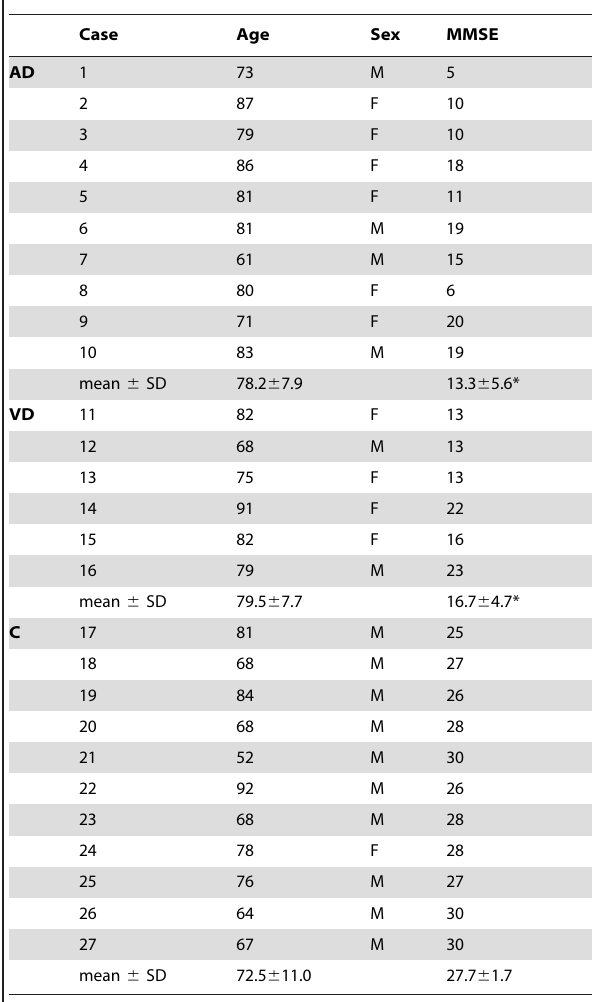
Table 1. Characteristic of all